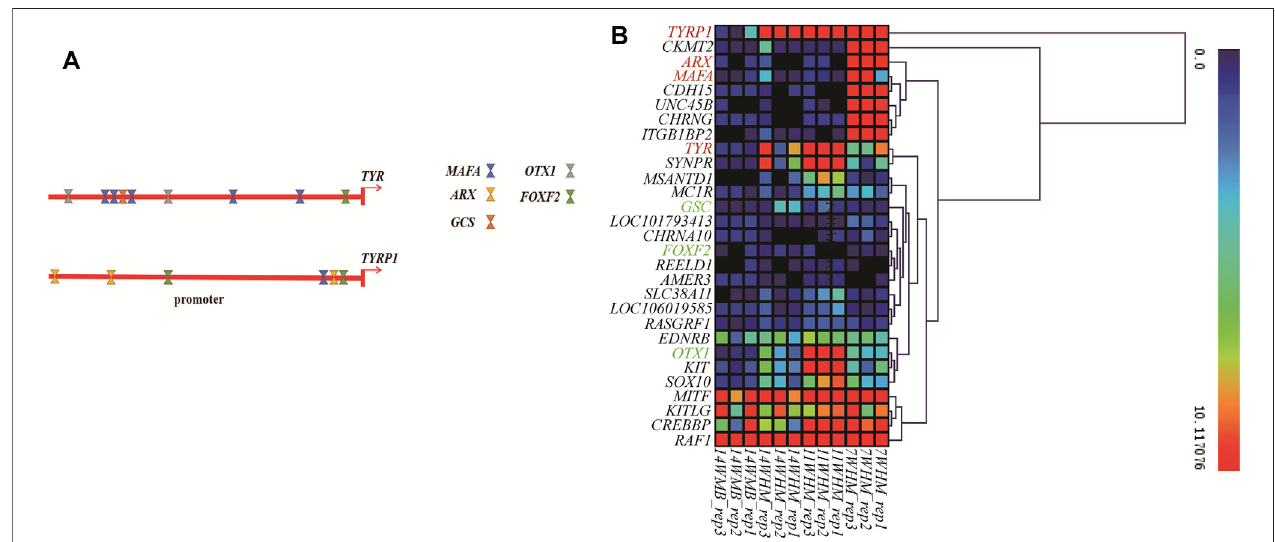
FIGURE 5 | The effect of transcription factors on TYR and TYRP1 gene expression. (A) The TF binding sites of the TYR and TYRP1 promoters were predicted. (B) Some pigmentation genes and 18 causative genes were expressed in 12 male samples. We used the FPKM results for the above samples for heat map